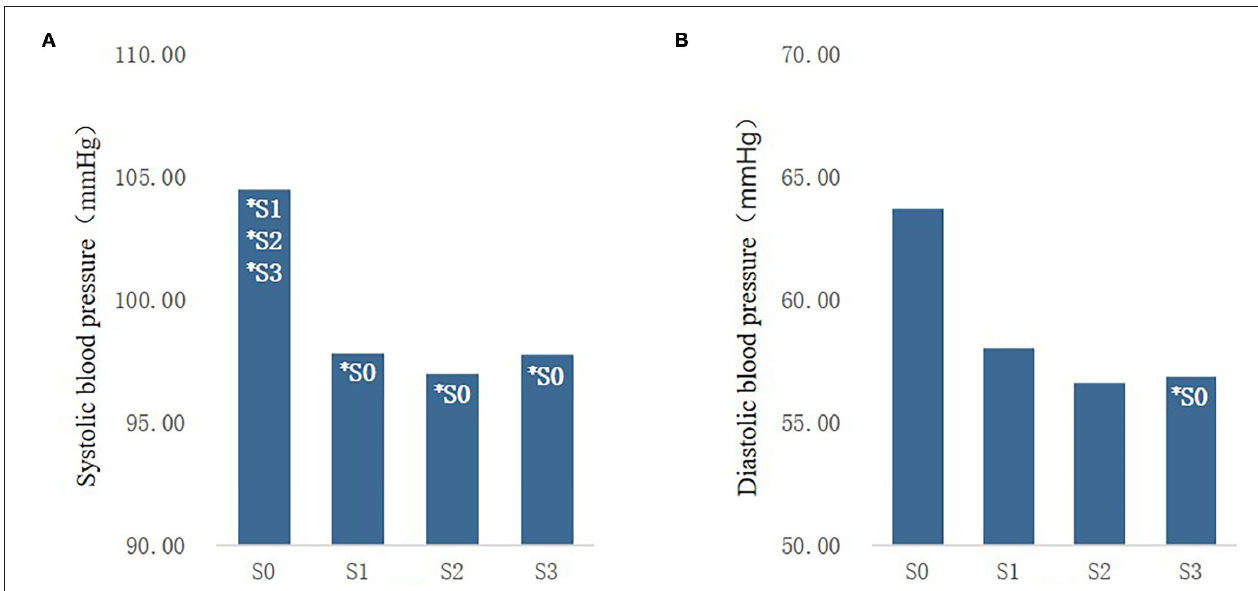
FIGURE 9 | Comparison of systolic blood pressure (A) and diastolic blood pressure (B) under different sound combinations.